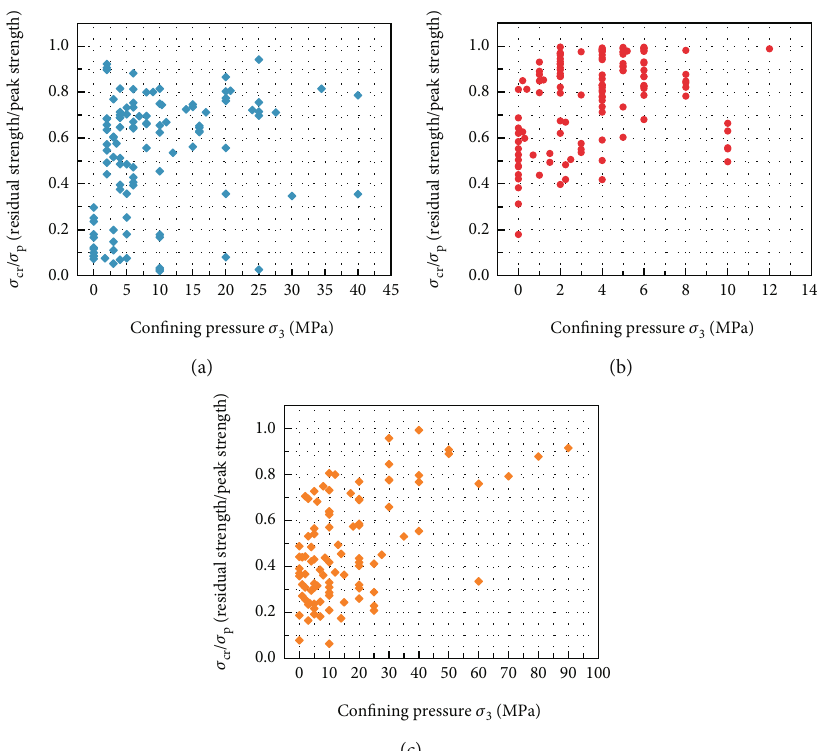
Figure 8: Analysis of variation of residual strength to peak strength ratio with con fi ning pressure: (a) raw coal, (b) briquette composed of soft coal, and (c) soft